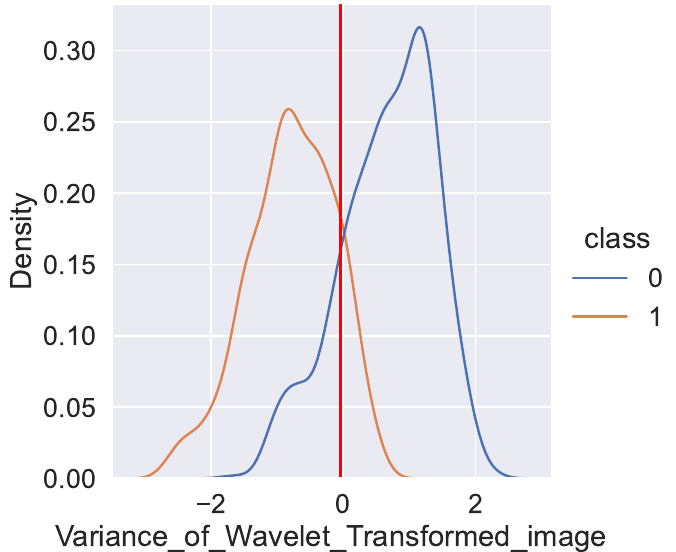
Figure 13. the threshold value learned by the explainable layer ExpL (shown as vertical red line) and the density function for the feature variance_of_the_wavelet_transform discriminated per class (class 0 is shown in blue, and class 1 is shown in